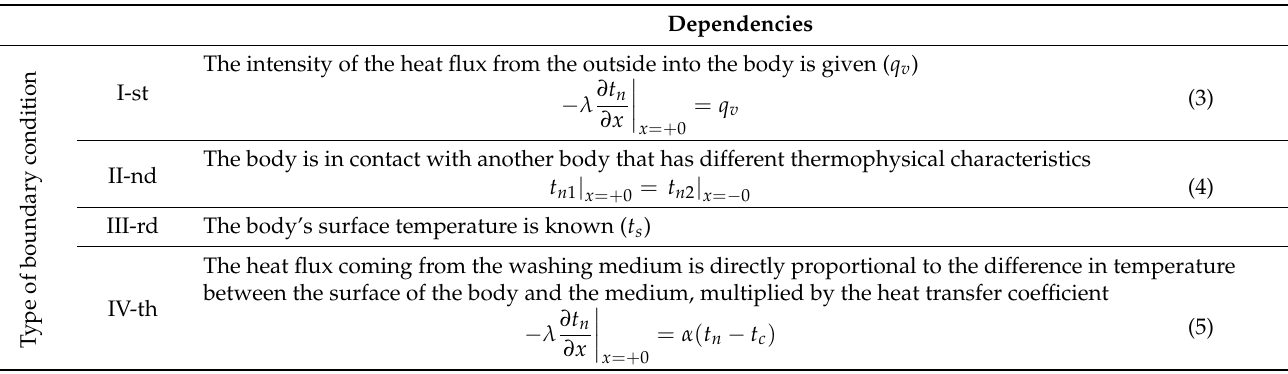
Table 1. Modified list of boundary conditions.